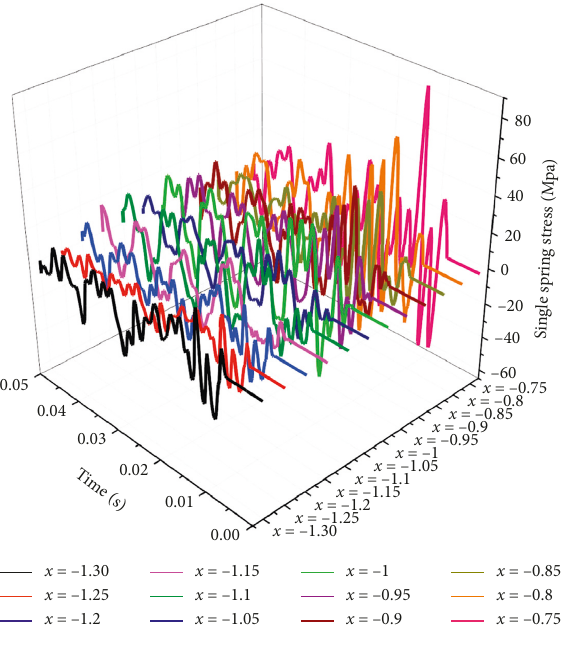
Figure 23: Spring stress.